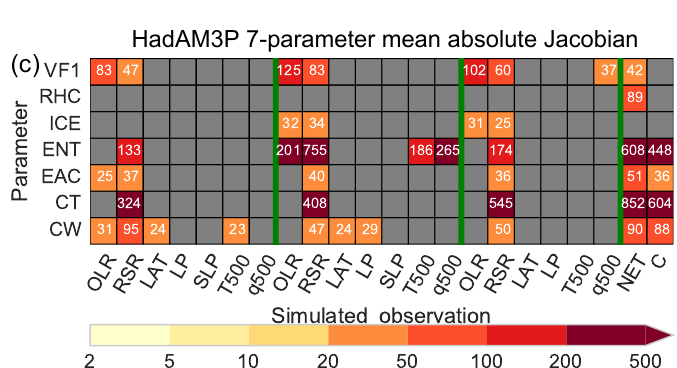
Figure 9. Mean of absolute Jacobian for 7- (a) , 14- (b) and HadAM3P 7- (c) parameter cases. All values are normalised by parameter range and internal variability (see main text). Colours change logarithmically using scale at bottom of plot. Gray regions are where absolute Jacobian, for one evaluation, is not significantly different at 90% level from zero (see main text). The y axis shows parameter names shortened to first three characters while the x axis on bottom plot shows simulated observations with region deleted. Observations are organised into three groups of seven as northern hemispheric extra-tropics, tropics and southern hemispheric extra-tropics split by green vertical lines. Also shown, on the right, are the net flux (Net) and cost